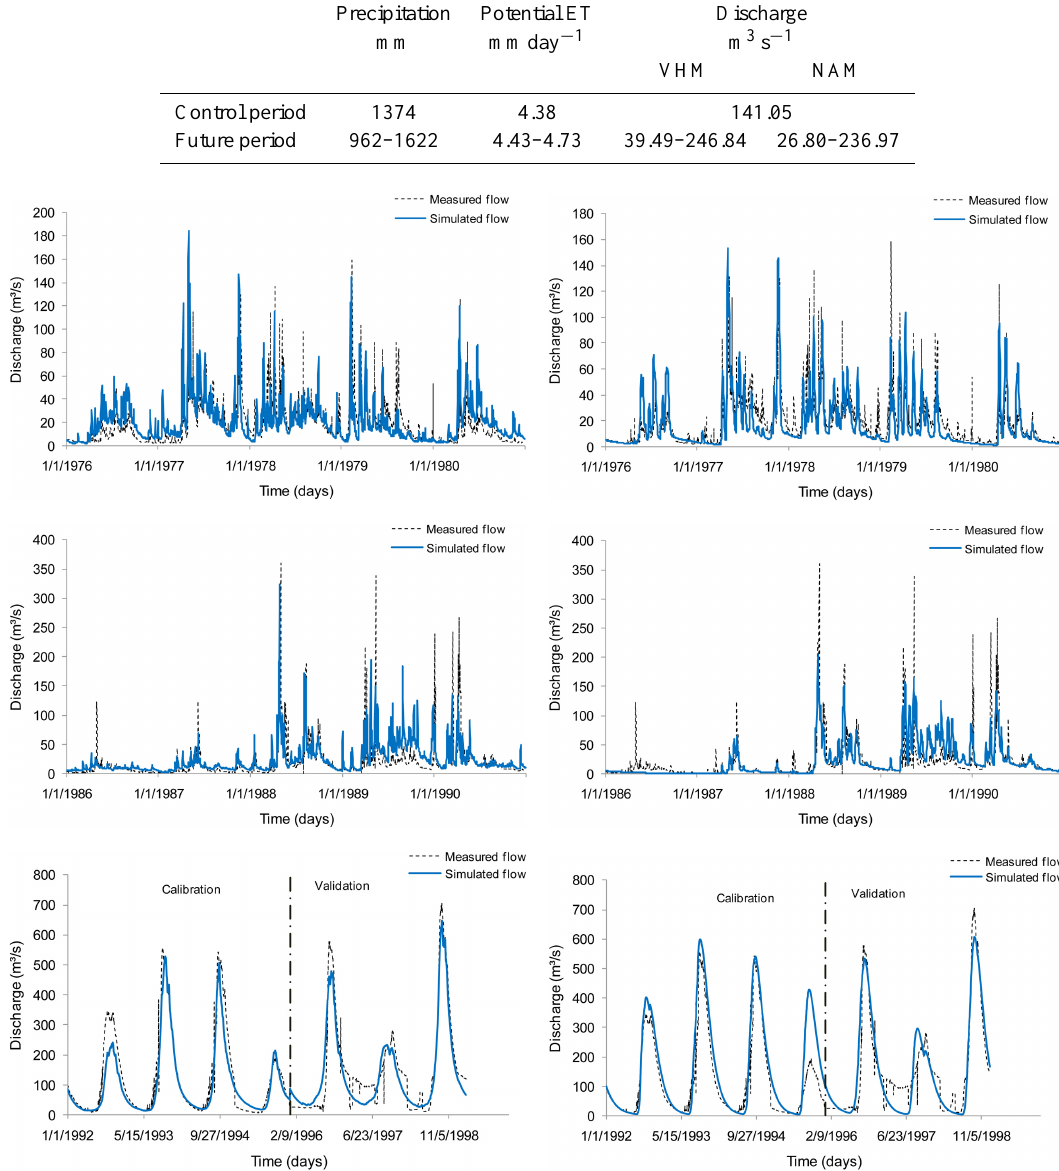
Table 5. Mean annual values of rainfall, ETo and flow of Lake Tana catchment for the control (1991–2000) and future (2046–2065) period.